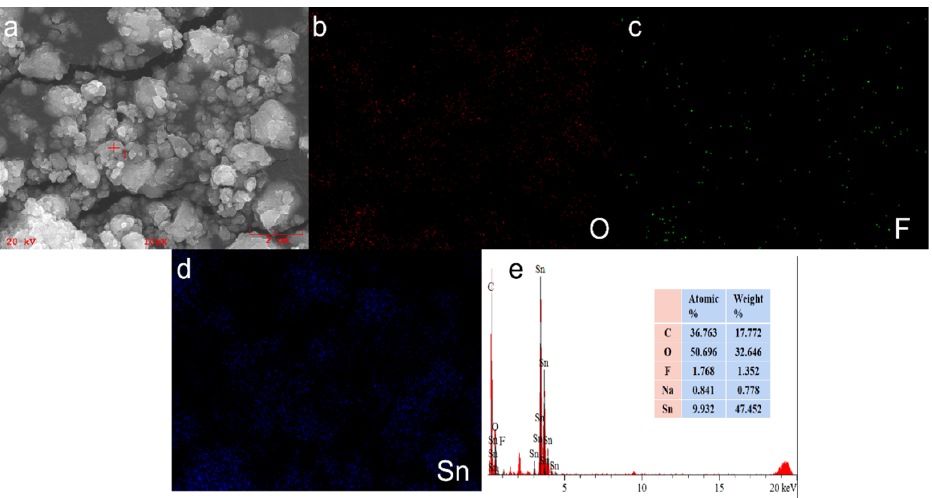
Figure 3. Mapping points of ( a ) SEM, ( b ) O, ( c ) F and ( d ) Sn elements of S2 sample. EDS spectrum and ( e ) contents of S2